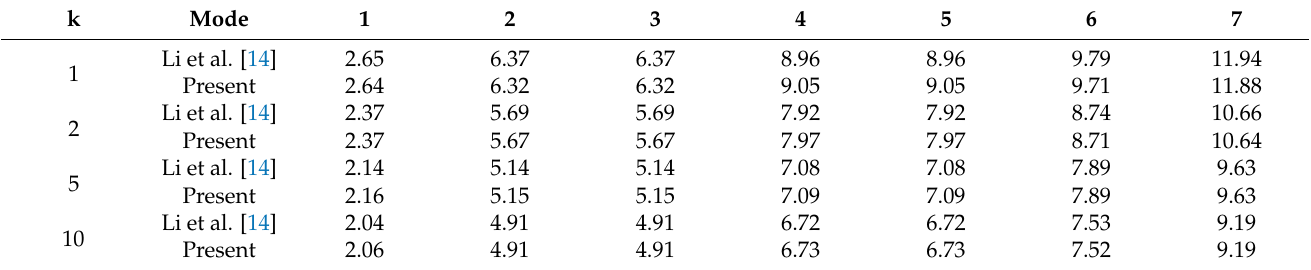
Table 4. Natural frequency parameters for simply supported FGM square plates exposed to a linear temperature rise of 300 K across the thickness.